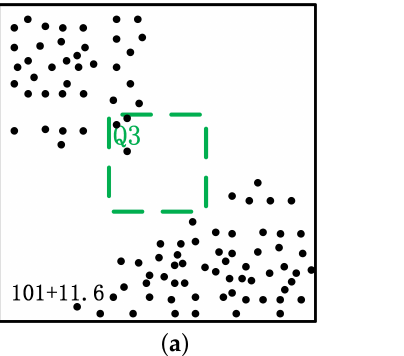
Figure 5. The relationship of non-uniform data distribution and partition structure. ( a ) example of non-uniform distribution; ( b ) corresponding partition and range